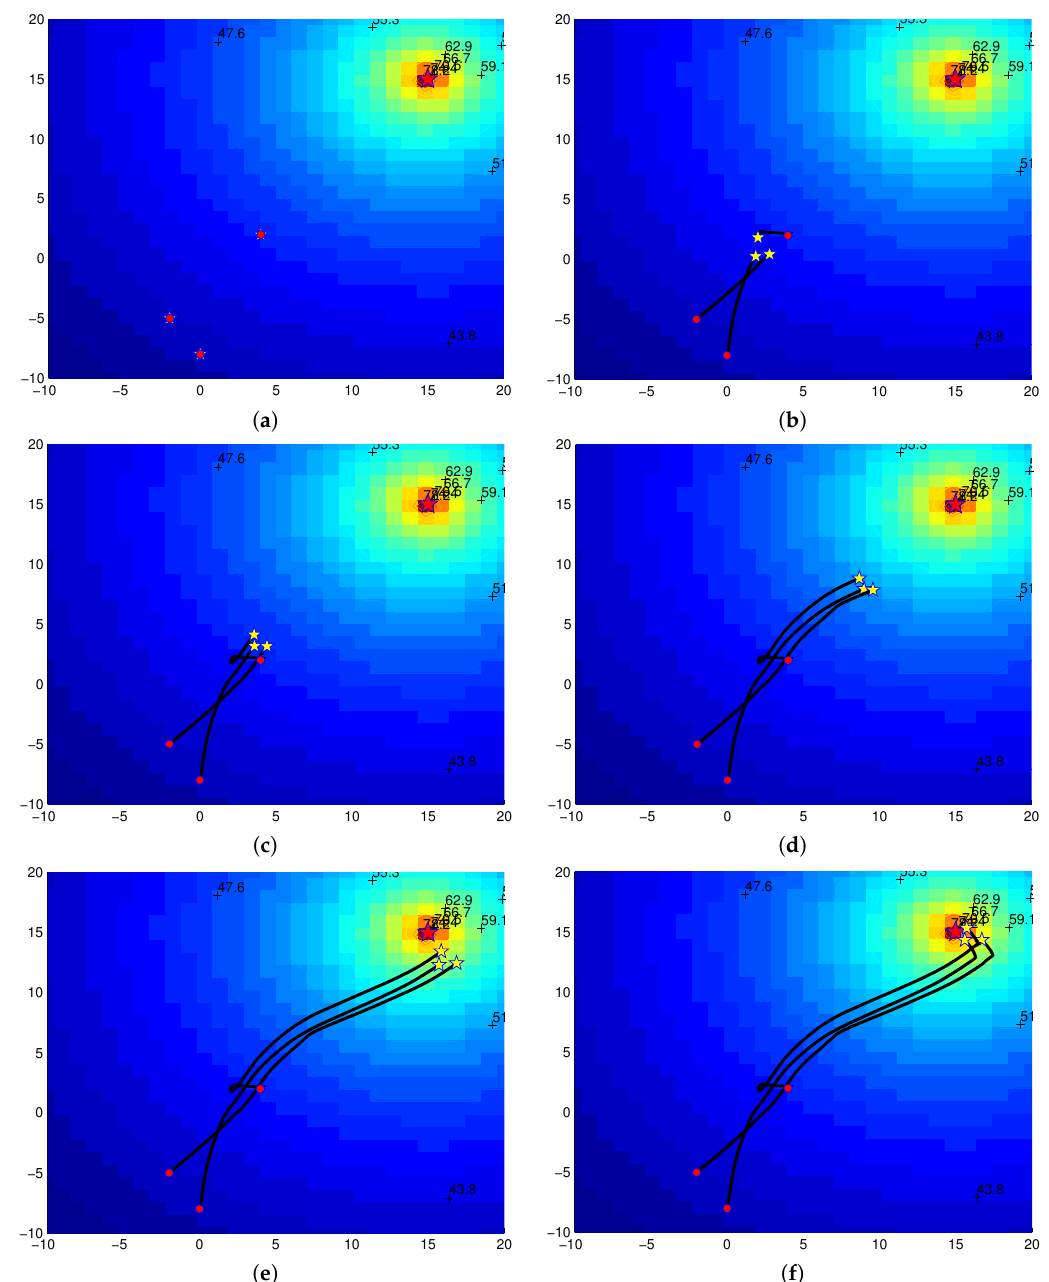
Figure 5. Movement trajectories of three robots for Case 2 where the red points denote the initial positions, the black lines are the trajectories of three robots, the yellow small stars are the current positions and the red big star refers to the signal source. The colors of the background represent the signal strength and are also labeled by the numbers. The signal strength increases with the decrease of the distance from the source. ( a ) t = 0 s; ( b ) t = 5 s; ( c ) t = 10 s; ( d ) t = 15 s; ( e ) t = 20 s; ( f ) t = 30